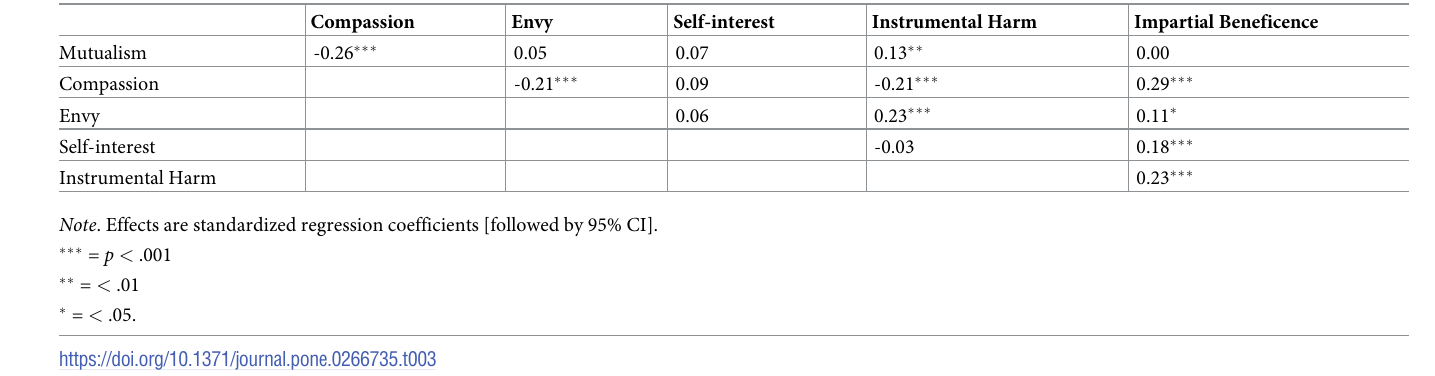
Table 3. Correlation of mutualism with other motives (Study